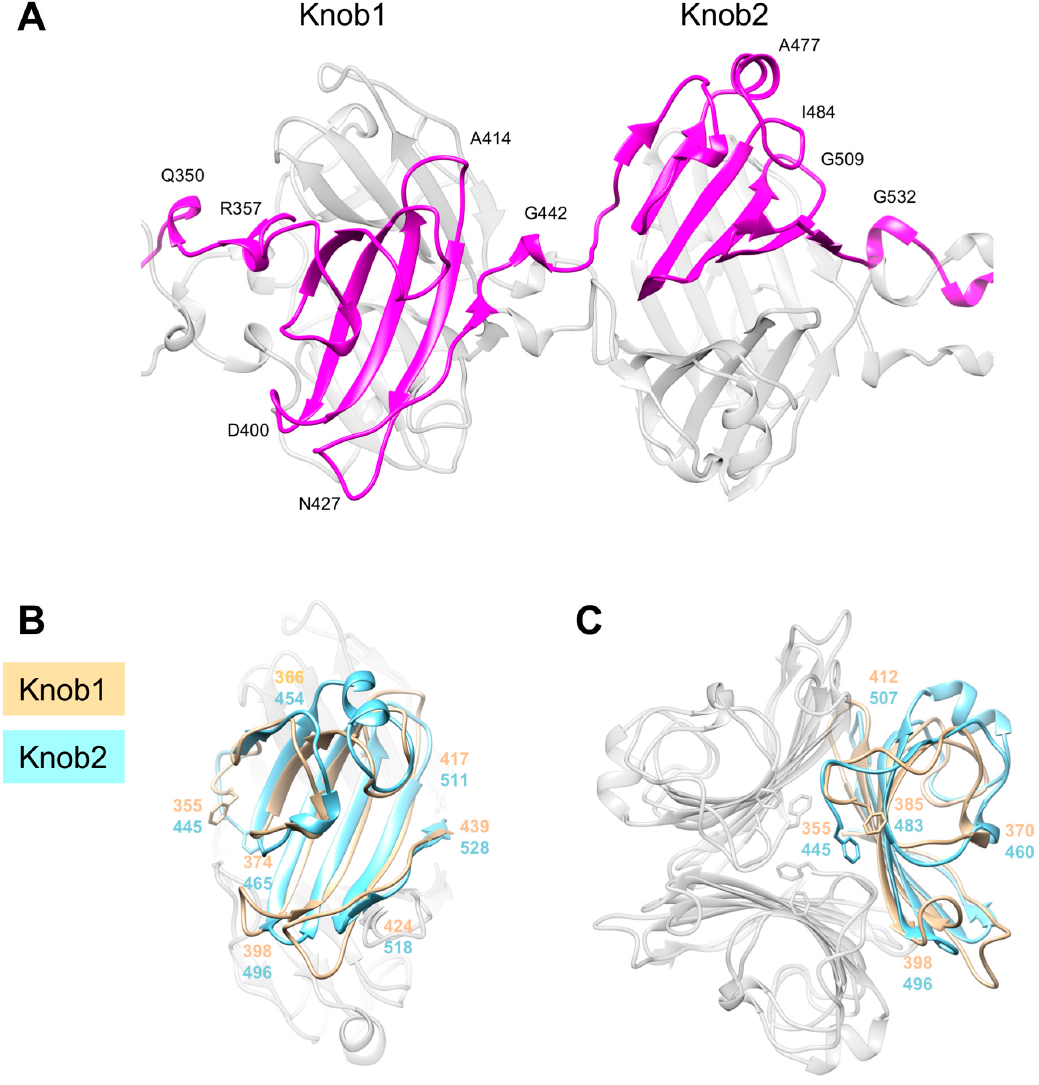
Figure 4. Structure of the two tandem Knob domains Knob1 and Knob2. ( A ) The trace of one of the three chains comprising the trimer. A side view ( B ) and an N-to-C end-on view ( C ) of the superimposed Knob1 and Knob2 domains. Residues are numbered with the color code of the corresponding domain. The R2 fiber model was used in all panels.